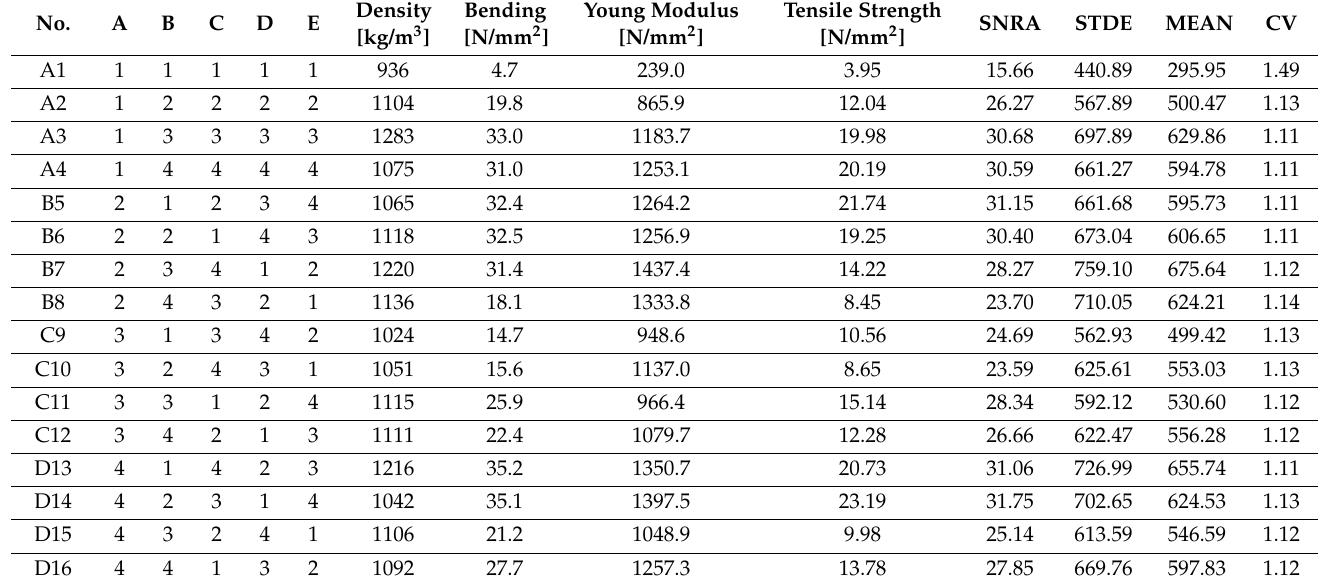
Table 3. Experimental design using L16 array and experimental